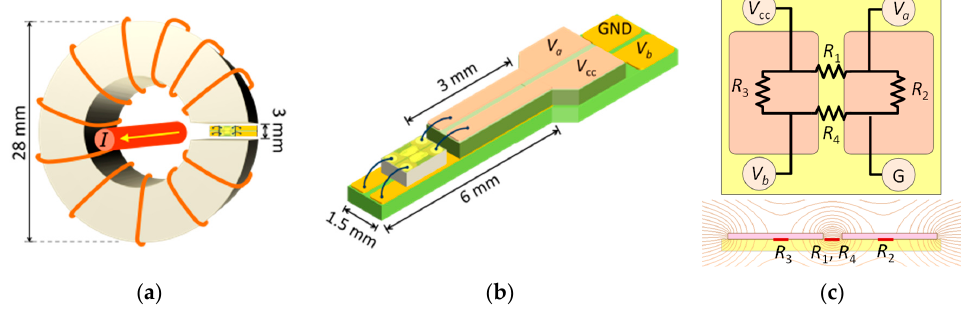
Figure 1. Schematics of the current sensor: ( a ) GMR sensor with a C-shaped ring-core made of ferrite; ( b ) wiring of the spin-valve chip mounted on assembled printed-circuit boards; ( c ) schematic layout of a spin-valve GMR bridge sensor with a flux concentrator.